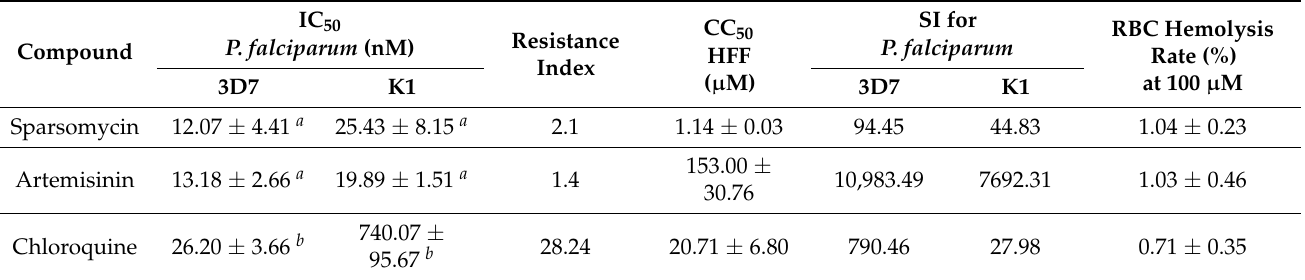
Table 1. Summary of the in vitro activities of sparsomycin compared with the positive controls